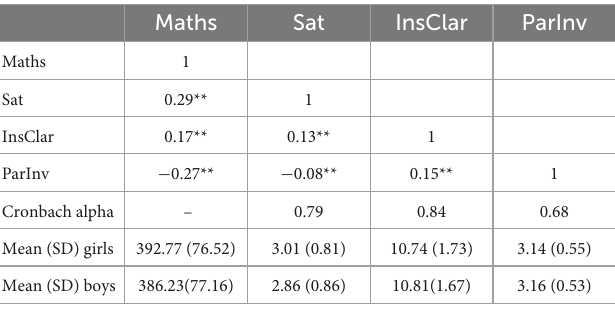
TABLE 1 Summary of correlations and means by